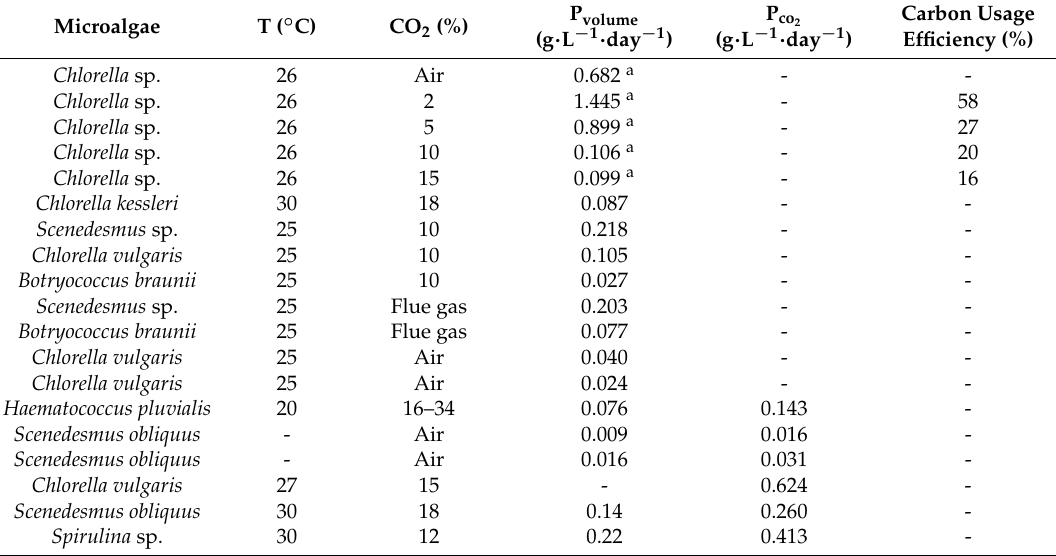
Table 5. CO 2 and biomass productivity for CO 2 mitigation species. Adapted from